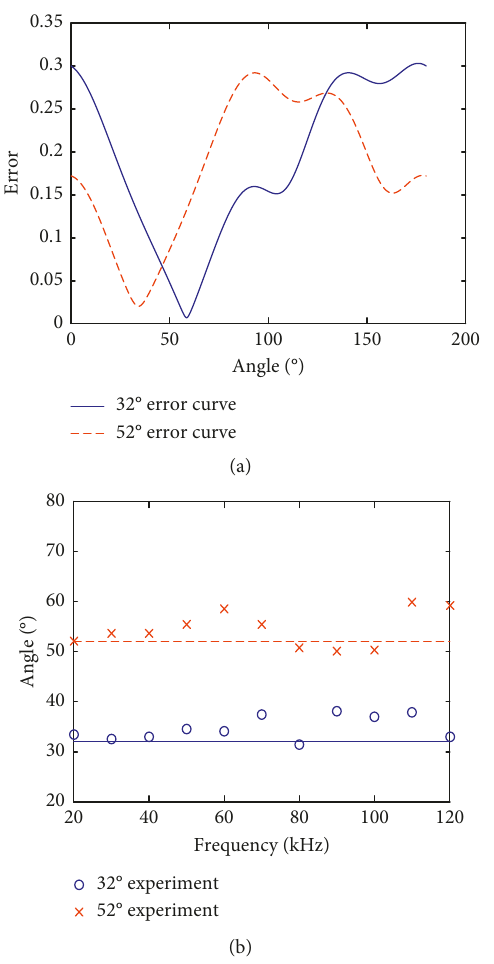
Figure 12: Test results of the Lamb wave propagation direction: (a) error curve in the central frequency of 60kHz; (b) angle estimation